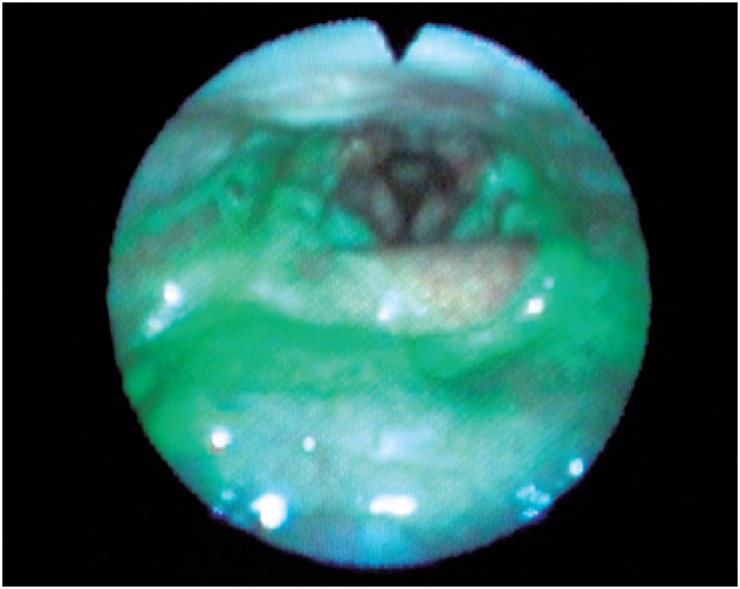
Resíduo de alimento em valéculas, seios piriformes e região retrocricoídea, com penetração e aspiração laringotraqueal, com tentativa de limpeza da fenda glótica, mas sem sucesso